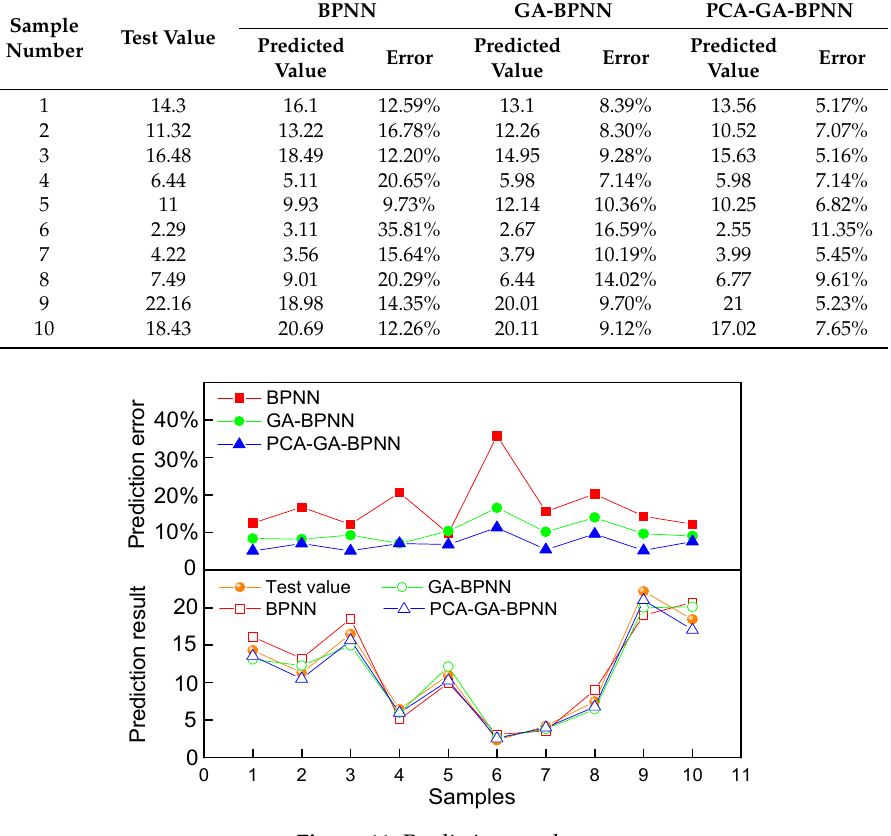
Figure 11. Prediction results.